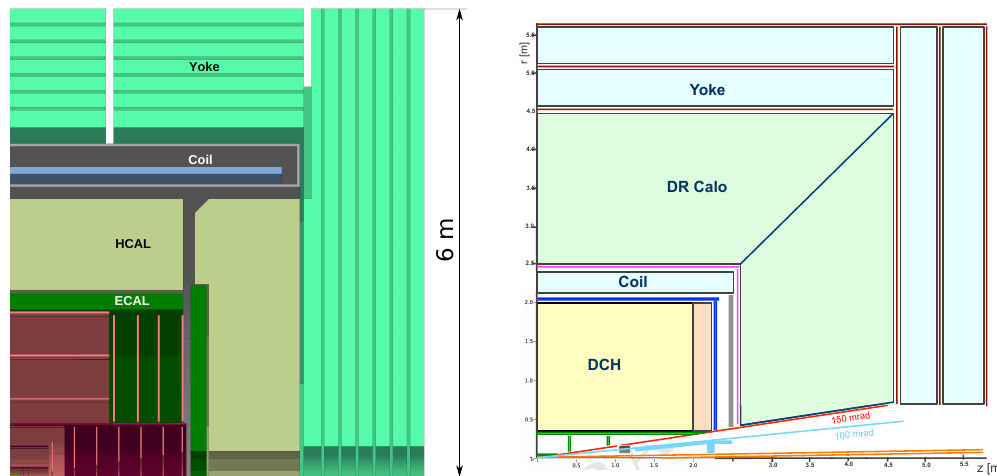
Figure 1: Vertical cross sections showing the top right quadrants of CLD (left) and IDEA